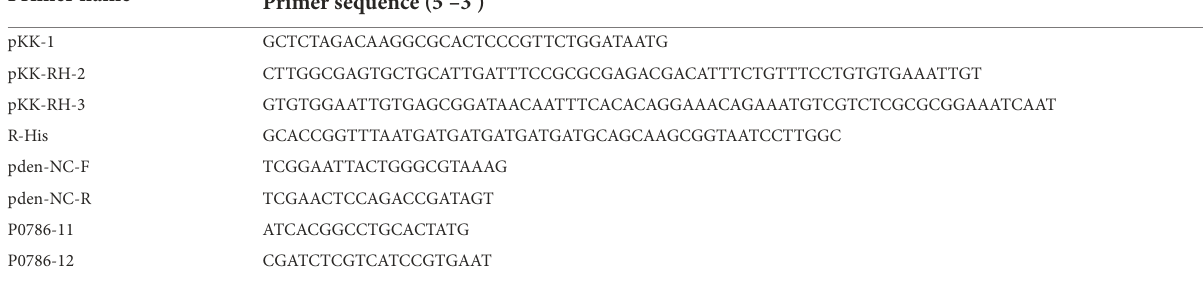
TABLE 2 Primers used for plasmid